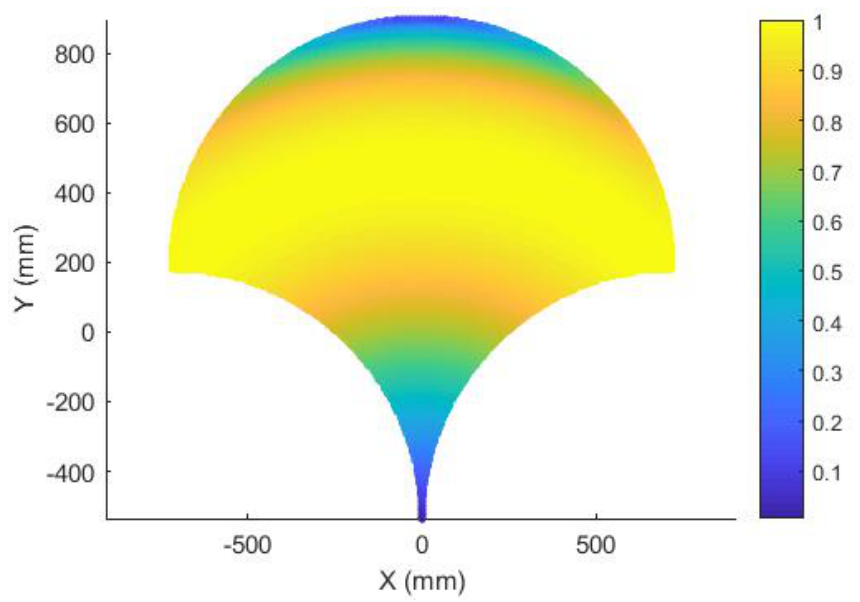
Figure 11. Transmission Index distribution in the workspace.